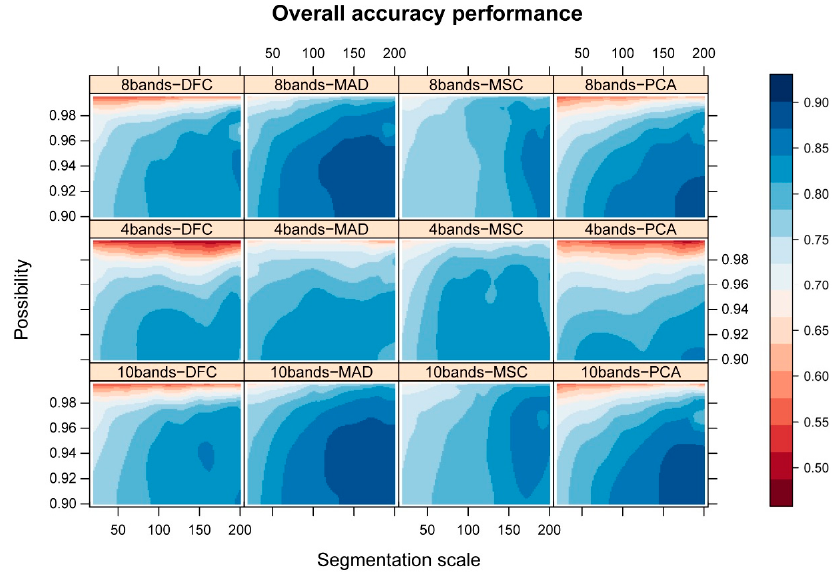
Figure 5. Overall accuracy of change detection for Study site 2. (for an explanation, see caption for